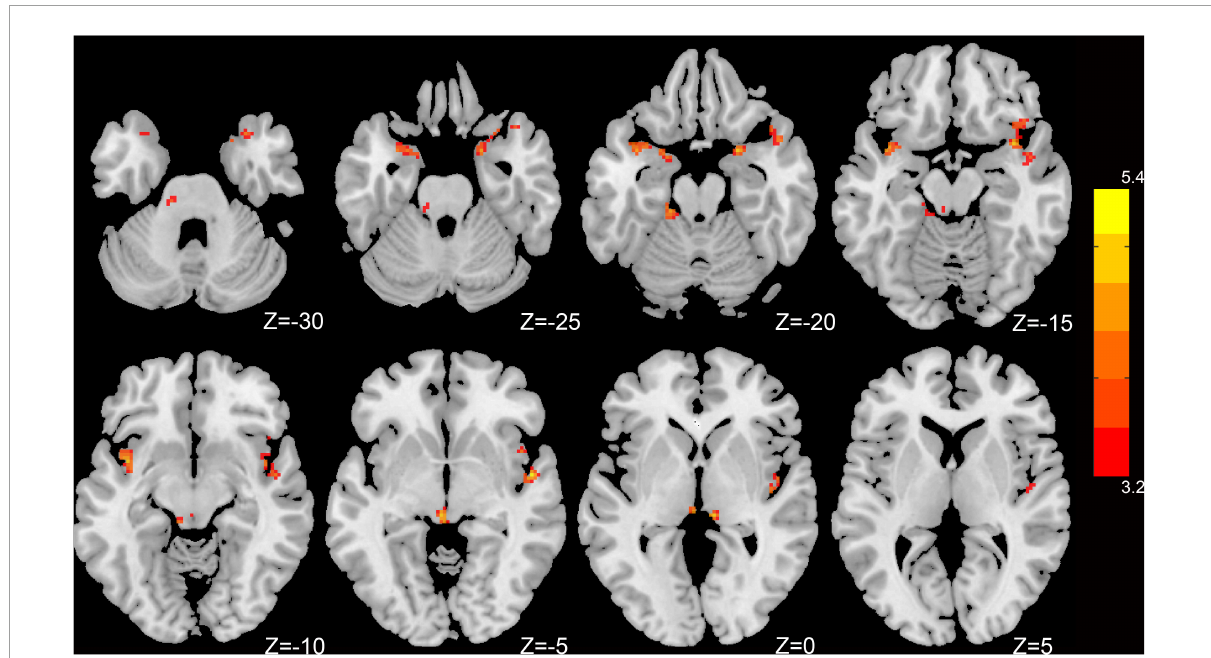
FIGURE1 Dynamic intrinsic brain activity with significant intergroup differences in dfALFF between the CI group and HC group. Cluster-level p < 0.05, GRF corrected. Red colors indicate significantly increased dfALFF in CI patients. The right color bar indicates t -values from a global cluster-based 2-sample t -test